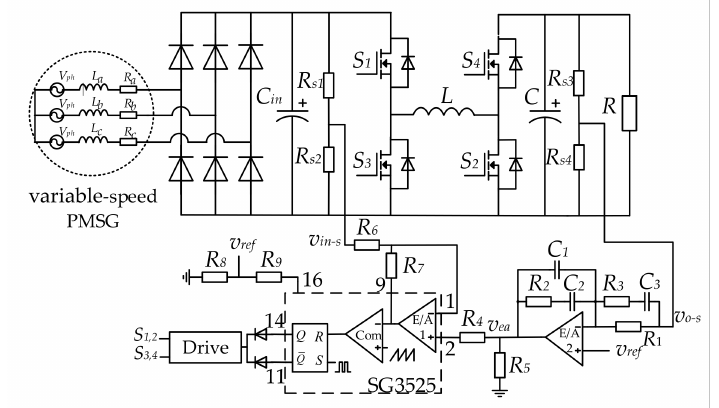
Figure 16. FSBB converter under synchronous switching control scheme with IVFF.